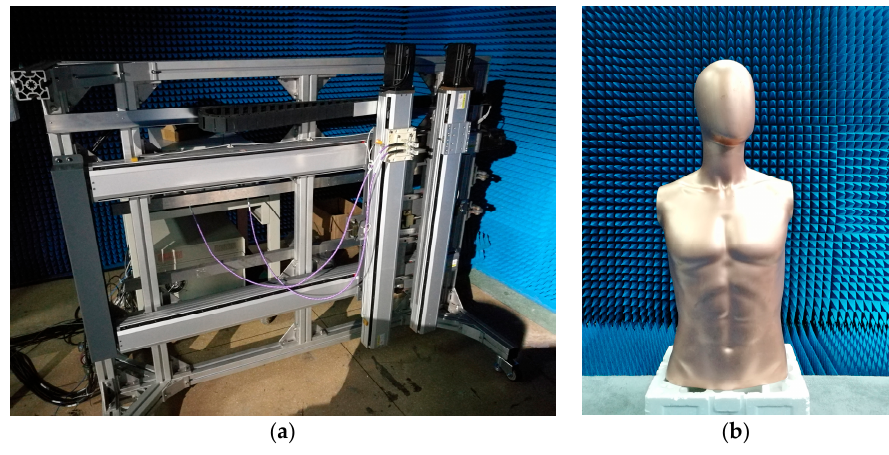
Figure 8. Experimental scene. ( a ) Experimental system; ( b ) Optical image of the mannequin.